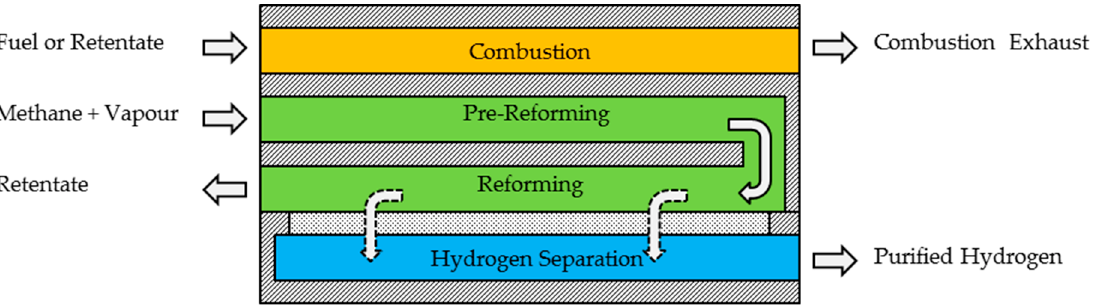
Figure 1. Rough scheme of the combination of the three functionalities (combustion for heat supply, reforming and hydrogen separation) of a fully integrated methane steam reformer in one module.